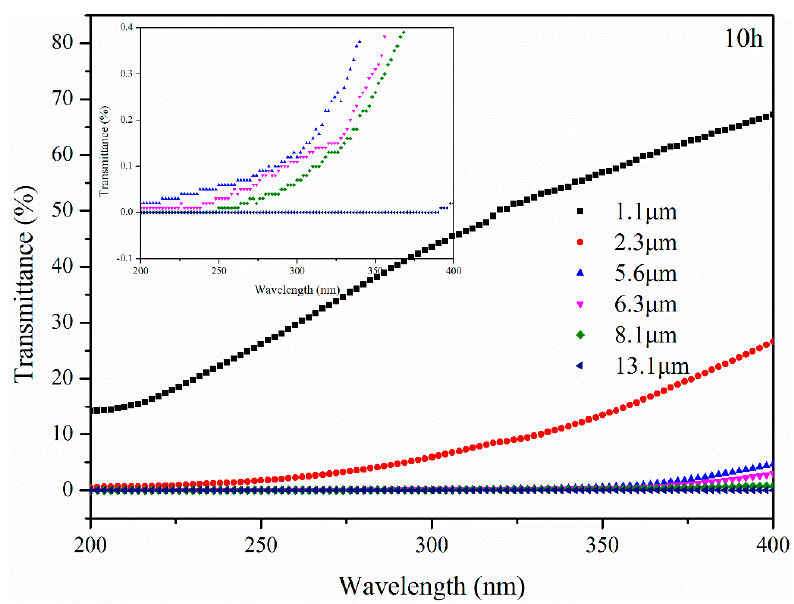
Figure 14. Transmittance of bitumen with different thickness after UV aging for 10 h.